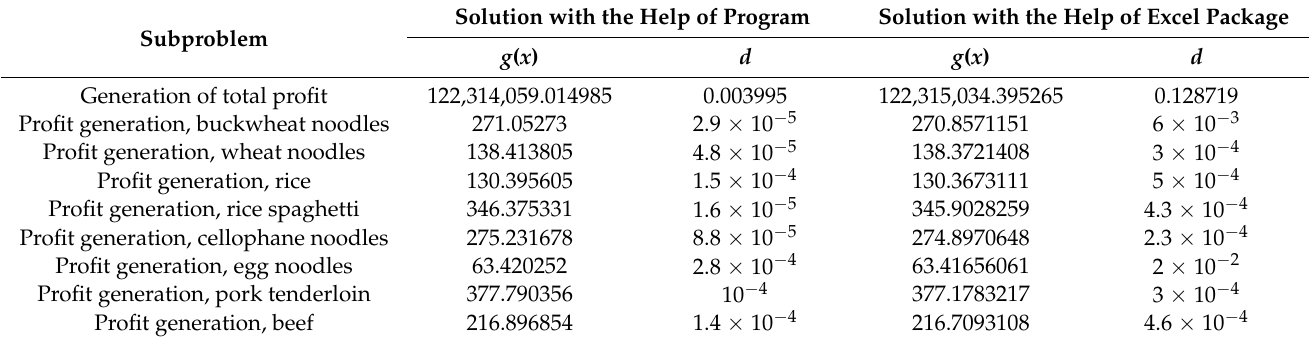
Table 5. Results of solving the problem when minimizing the sum of squares of argument changes.